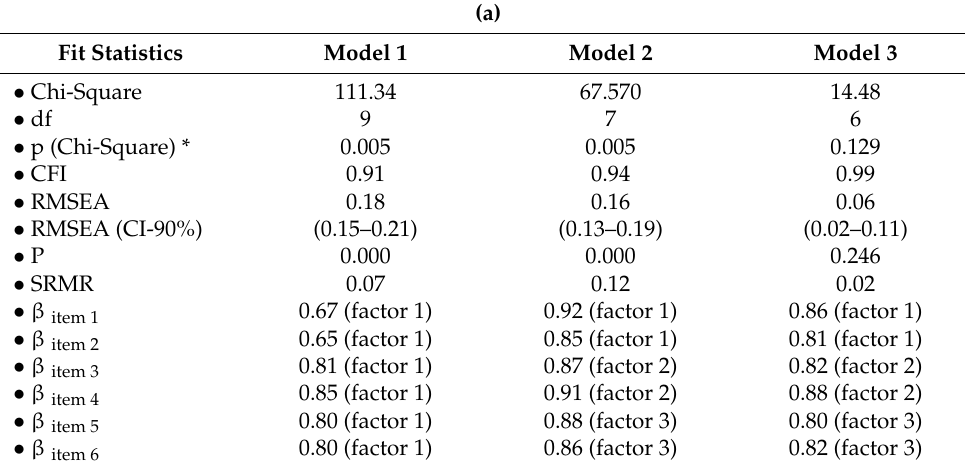
Table 2. ( a ) Selected Indices for Fit Statistics and standardized regression weights for items of Confirmatory Factor Analysis of the self-report version of the CHC-/YHC-SUN-SF ( n = 469). ( b ) Selected Indices for Fit Statistics and standardized regression weights for items of